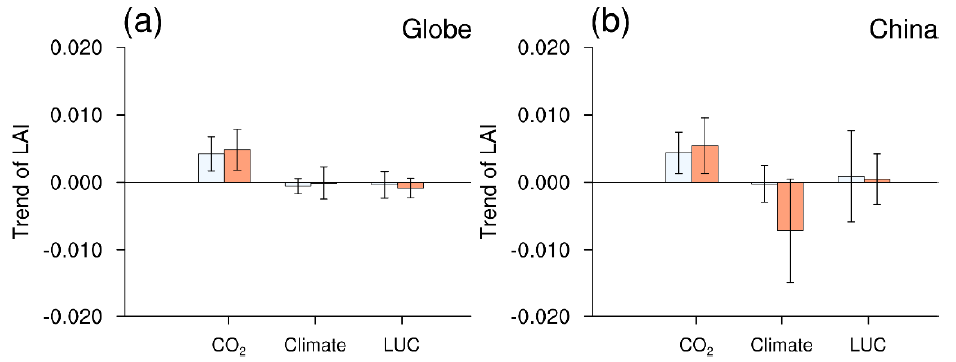
Figure 3. ( a , b ) Trends in averaged LAI derived from TRENDY models driven by rising CO 2 concentrations (CO 2 ), climate change (Climate), and land-use change (LUC). Horizontal lines indicate ± σ .